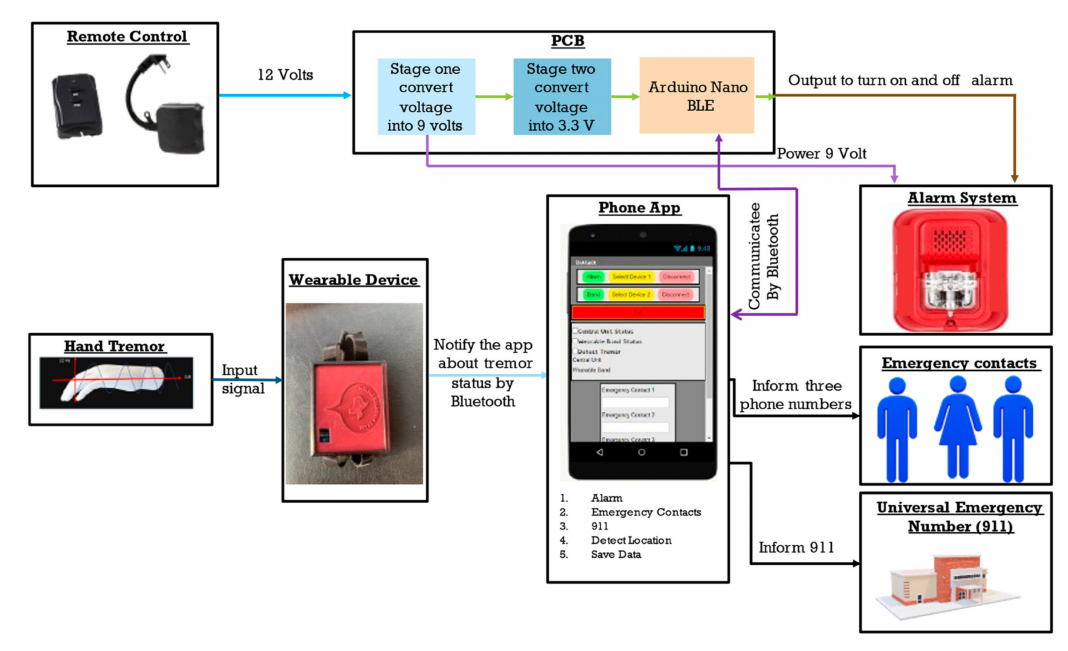
Figure 1. DiAtack Conceptual Block Diagram.